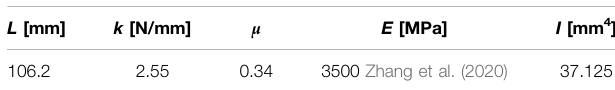
TABLE 1 | Parameter values to calculate bending de fl